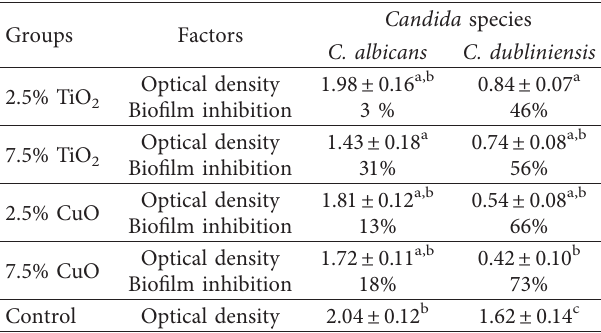
Table 2: Means ± standard deviations, biofilm inhibition (%), and multiple comparisons of optical density of the study groups for Candida species. Groups